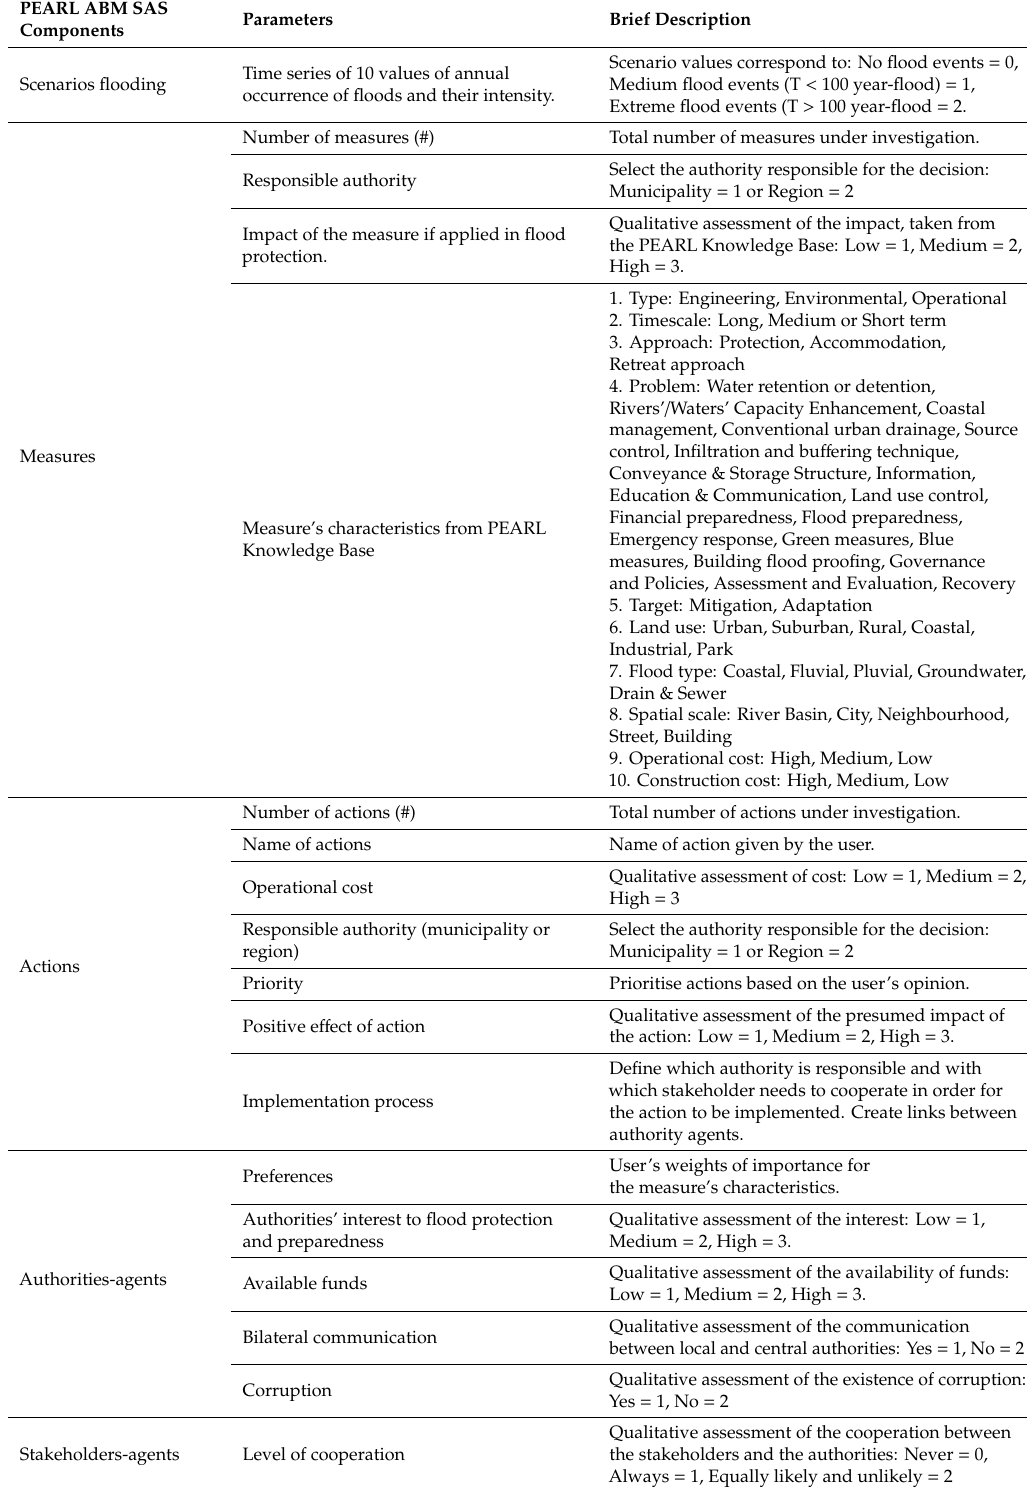
Table A1. Low level parameters of PEARL ABM